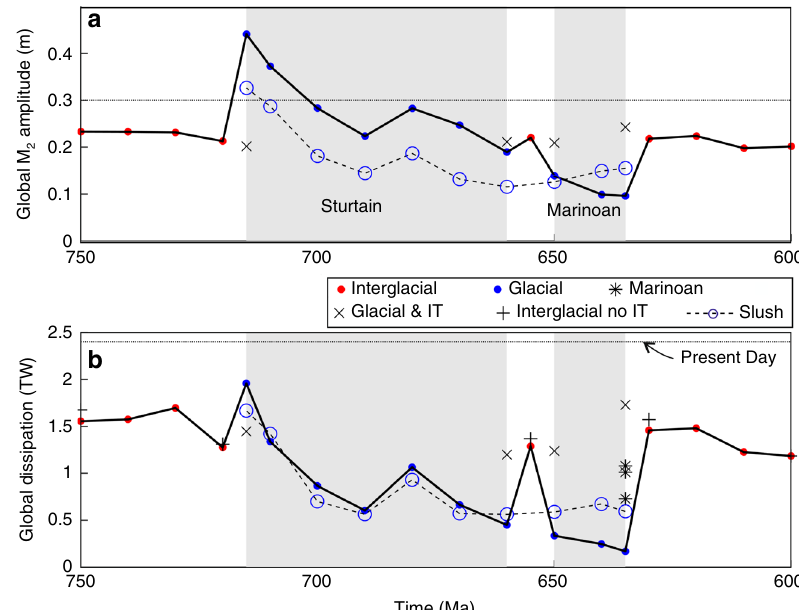
Fig. 2 The evolution of globally averaged tidal parameters during the Cryogenian. Globally averaged M 2 amplitudes ( a ) and integrated dissipation rates ( b ) throughout the period under consideration. The black solid line is the result from the set of simulations with conversion and no sea level change during interglacial periods (red dots), and a 500 m lowstand, no conversion, and increased bed friction during the glacial periods (blue dots). The x-symbols mark sensitivity simulations at the onset and end of glacial periods, in which non-glacial conditions were used, and the plus signs ( + ) mark simulations during interglacial periods without tidal conversion. The blue dashed line with circle markers shows the results for the Slushball with an ice-free band within 10 o from the equator. The horizontal black dotted lines mark present day values and the blue shaded areas mark the spans of the two